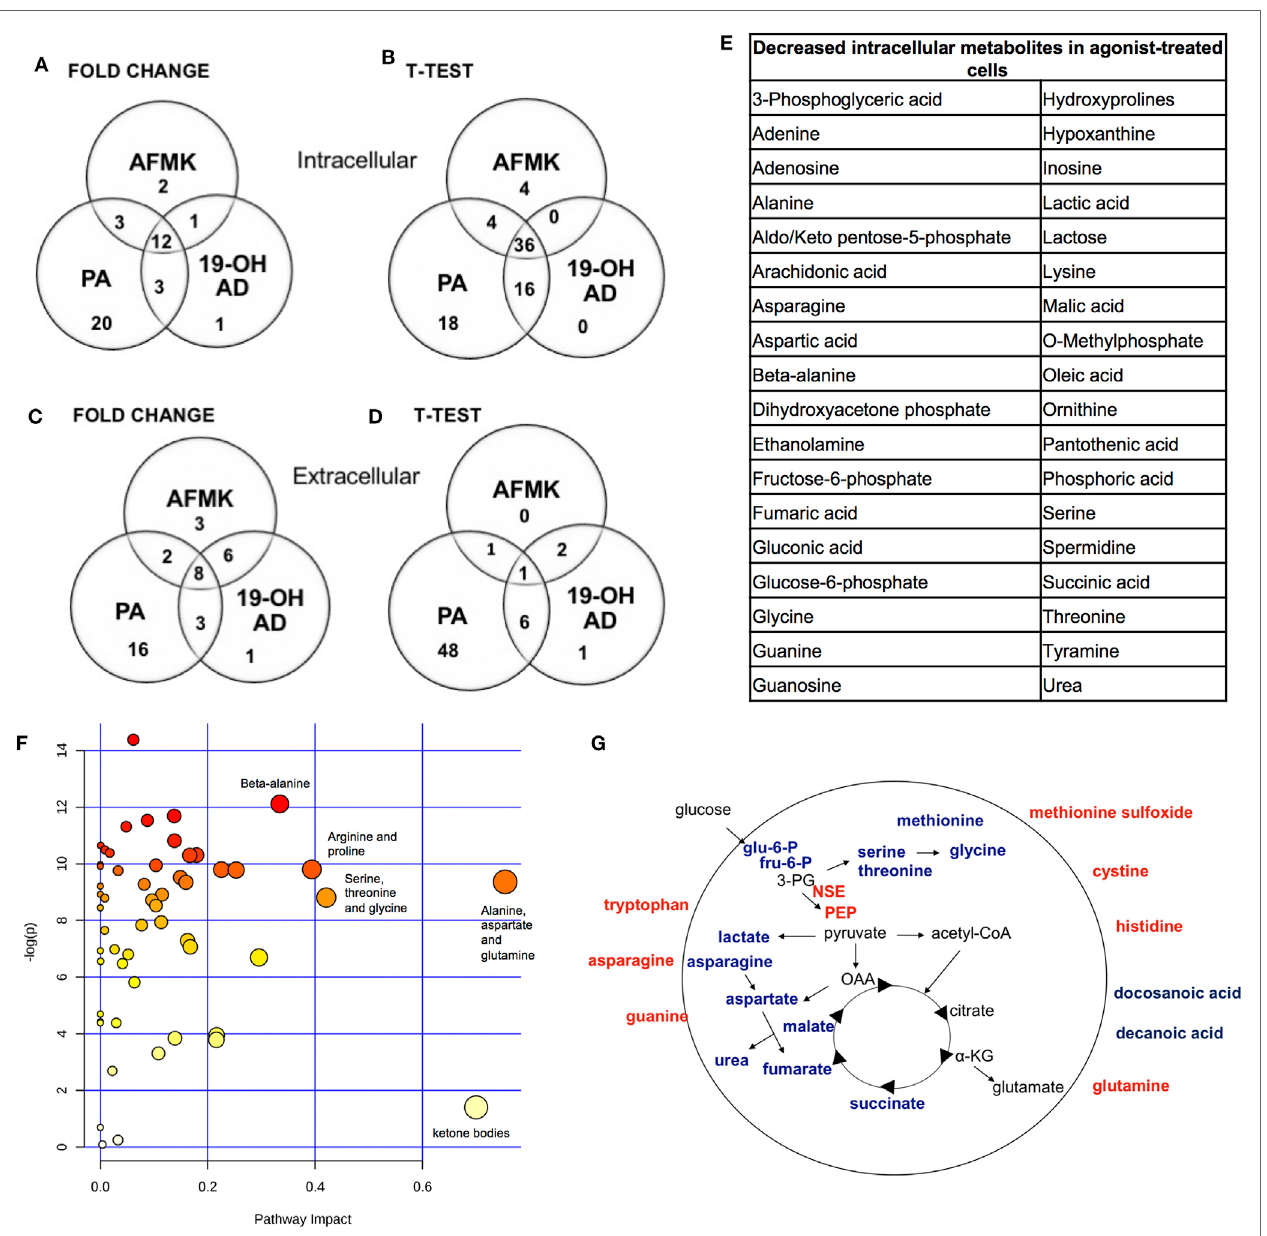
FigUre 4 | Most pronounced metabolic changes induced by activation of OR51E2 with selected agonists. Venn diagrams show the set of annotated intracellular metabolites differentially expressed by (a) fold change and (B) t -test analysis, and the set of extracellular metabolites identified by (c) fold change and (D) t -test. (e) In total, 36 annotated intracellular metabolites significantly decreased in all three treatments (see Figure 3B ). (F) Pathway analysis. The most pronounced pathways in 19-OH AD-treated cells. Pathways are displayed as circles, and the color and size of each circle are based on its P value and pathway impact value, respectively. The top-right area indicates the most significant changes in metabolites. (g) Schematic representation of cellular metabolites. Significantly increased metabolites are in bold red, and significantly decreased are in bold blue (PEP, phosphoenol pyruvate; OAA, oxalacetate; 3PG, 3-phosphoglycerate; α -KG, α -ketoglutarate). Increased neuron-specific enolase (NSE) catalyzes the formation of PEP and is also indicated in red.